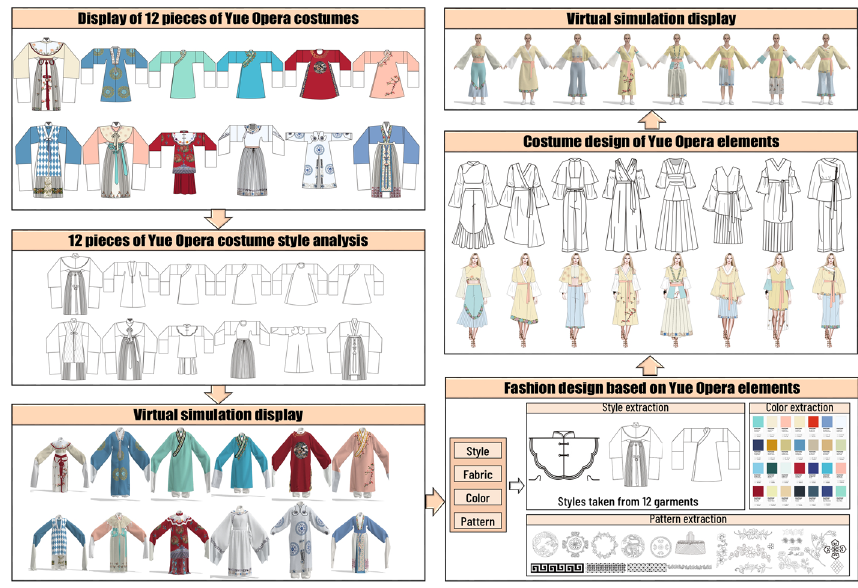
Fig. 1 Technical